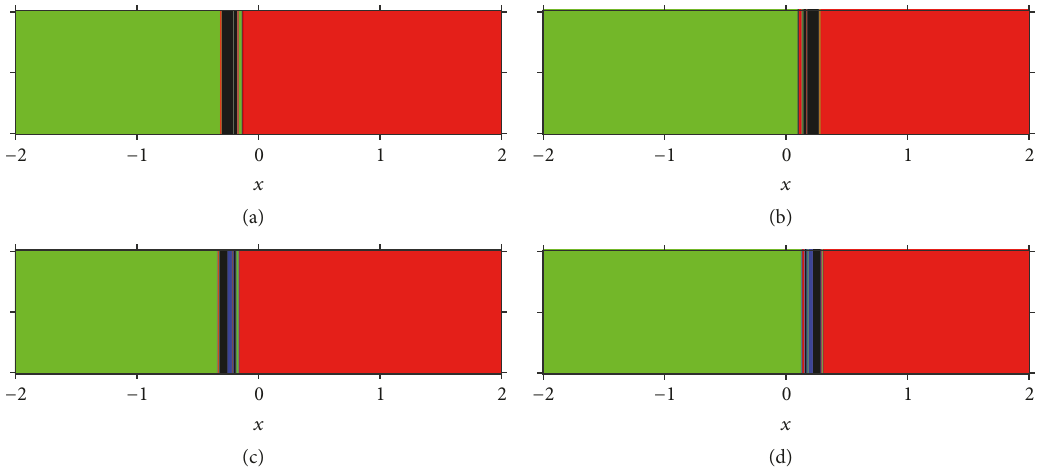
Figure 5: Dynamical lines of methods with (a) (𝛼,𝛾) = (−0.5,−0.5) , (b) (𝛼, 𝛾) = (−0.5, 0.5) , (c) (𝛼,𝛾) = (−1, −0.5) , and (d) (𝛼,𝛾) = (−1,0.5) (red: 𝑥 ∗ 1 , green: 𝑥 ∗ 2 , blue: 𝑥 ∗ ∞ , and black: others).